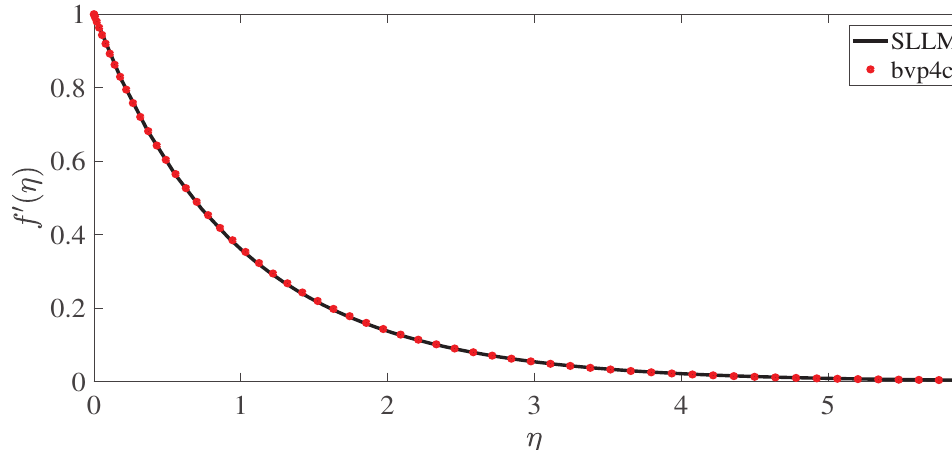
Figure 1. Solution comparison of bvp4c and SLLM approach for velocity profile.